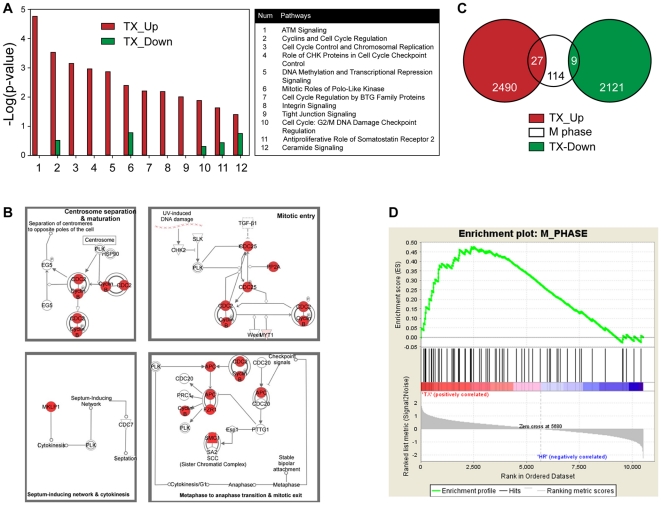
Enhancement of mitosis-phase genes and pathways with progression to chemotherapy-resistant disease.(A) Cell-cycle regulation pathways are significantly upregulated in the CRPC chemotherapy-resistant (TX) group compared with the CRPC chemotherapy-naïve group. (B) Ingenuity Pathway Analysis.(IPA) of the upregulated gene set demonstrates that the canonical pathway of mitotic roles of polo-like kinase is significantly associated with the CRPC chemotherapy-resistant group (P = 0.004). The P value is calculated by Fisher's Exact Test. The genes that are upregulated in the CRPC chemotherapy-resistant group and are involved in this pathway are color-coded in red. The other genes that are included in this pathway but are not in the upregulated gene set are indicated in white. (see text for identification of upreguated gene set in details). (C) Significant overlap of the upregulated gene set in CRPC chemotherapy-resistant tumors with M-phase (n = 27, P = 5.00E-7) compared with the downregulated gene set (n = 9, P = 0.416). (D) GSEA indicated that M-Phase was significantly enriched in the CRPC chemotherapy-resistant group at FDR<10%.